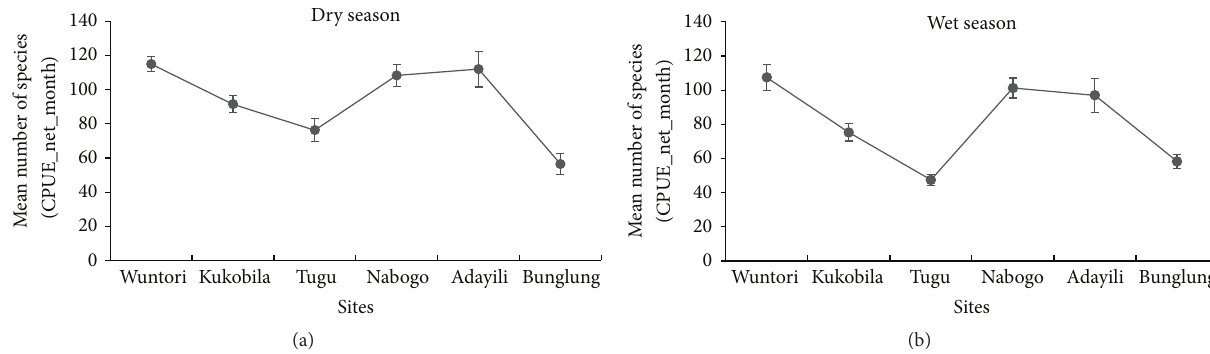
Figure 2: Variations in monthly catch per unit effort per net (CPUE) in the dry and wet season, across the six sites.